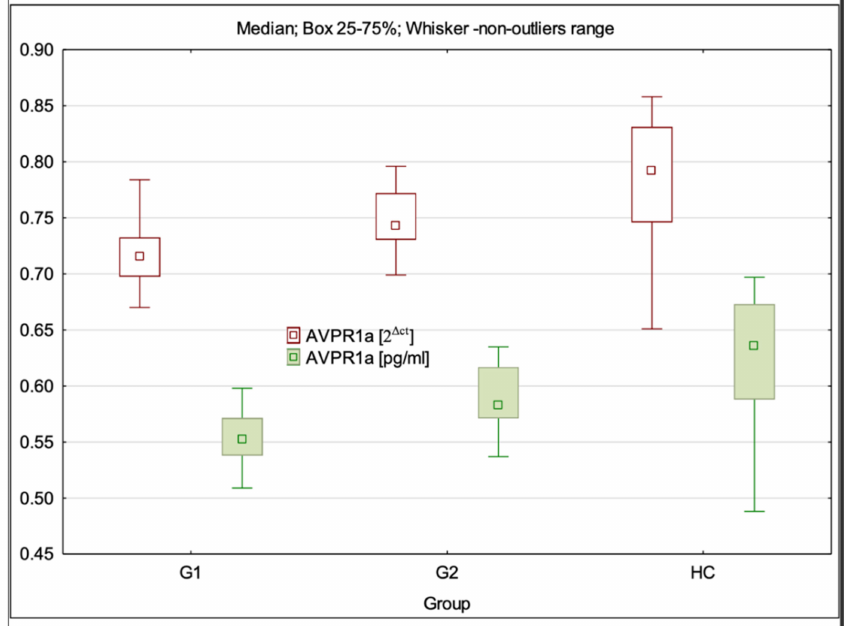
Figure 4. AVPR1a gene expression at the mRNA and protein levels in the studied population. The level of AVPR1a expression at the protein level was statistically significantly dif- ferent between the investigated groups (H = 28.36; p < 0.001). Dunn’s multiple comparison test showed that the AVPR1a levels were statistically significantly lower in G1 ( p < 0.001) than in the control group (HC). AVPR1a protein level in G1 was statistically significantly lower than in G2 ( p = 0.004). There was no statistically significant difference in AVPR1a expression at the protein level between G2 and HC groups ( p > 0.05) (Table 2, Figure